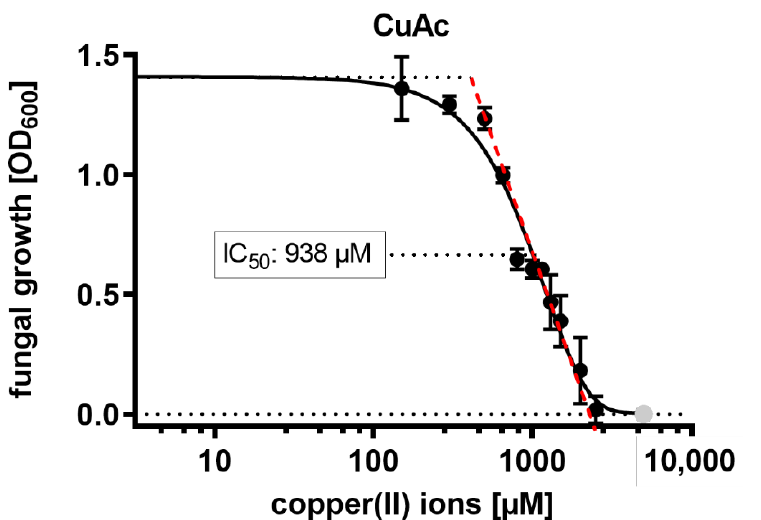
Figure 4. Antifungal activity of CuAc against F. graminearum. The IC 50 value was calculated via nonlinear regression analysis of GraphPad PRISM software. The concentration values were log-transformed for both calculation and visualization. Artificial data points to achieve a sigmoidal curve are marked in grey.